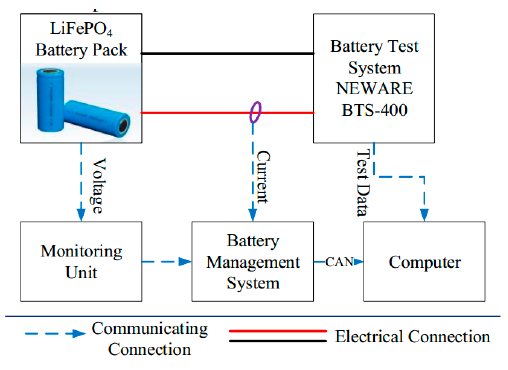
Figure 8. Test bench.